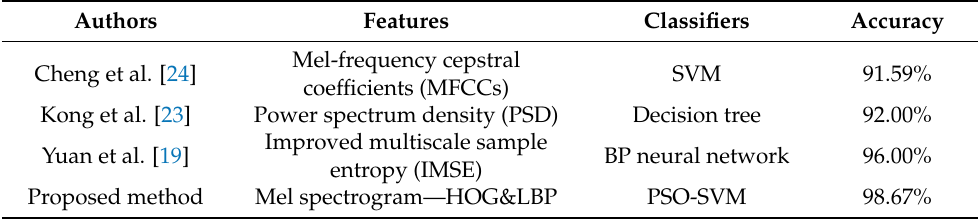
Table 7. The results of the proposed method compared with existing